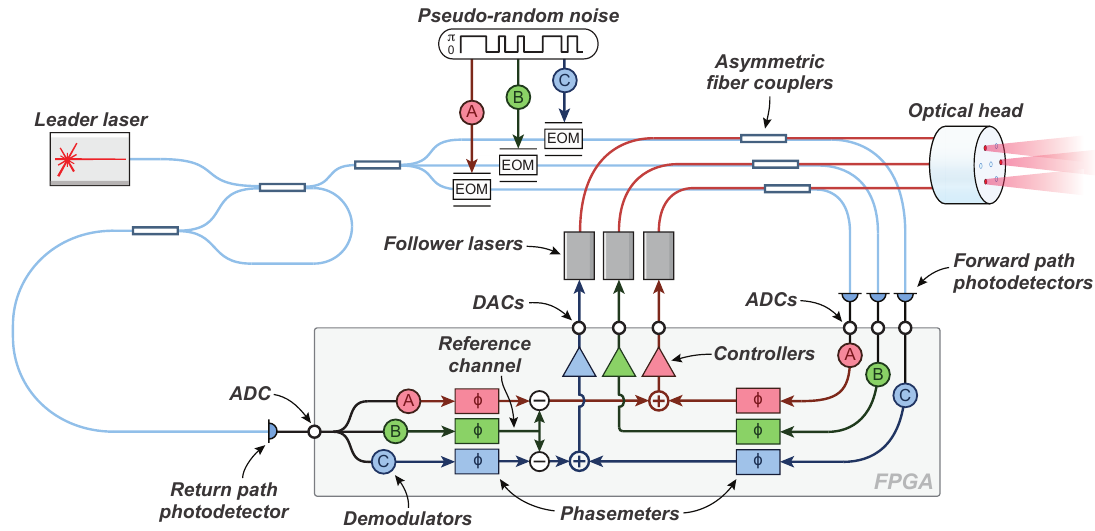
Figure 1. Idealized frequency-offset phase locked optical phased array using digitally enhanced interferometry and internal sensing. Three emitters are shown for clarity. The use of digitally enhanced interferometry enables this technique to support an arbitrarily large number of